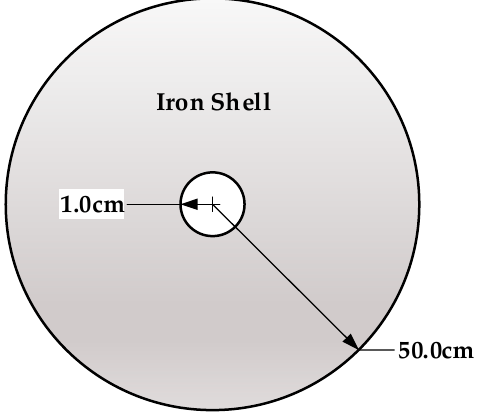
Figure 11. Simpli fi ed iron (Fe-56 only) shell geometry used in one-dimensional S N calculation. Figure 11. Simplified iron (Fe-56 only) shell geometry used in one-dimensional S N